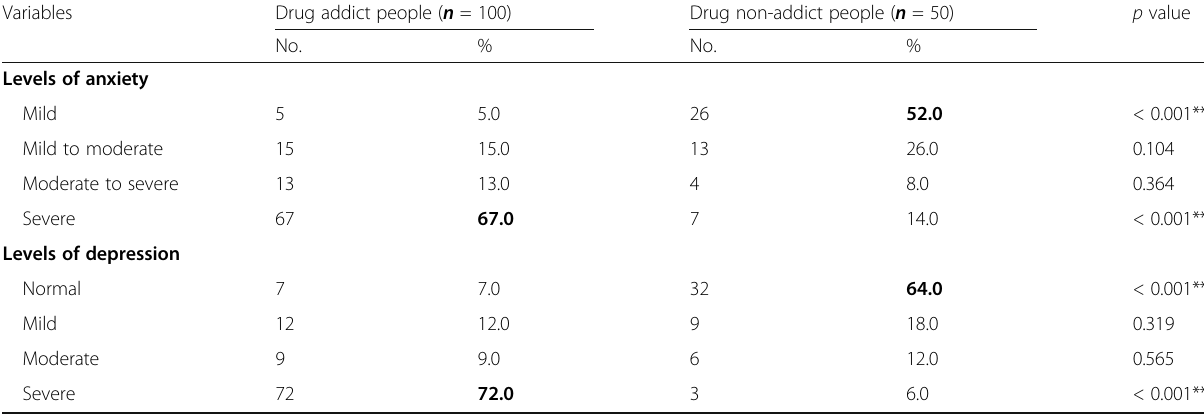
Table 4 Comparison between levels of anxiety and depression among SUD patients ( n = 100) and control group ( n = 50) according to HAM-A and HAM-D rating scales